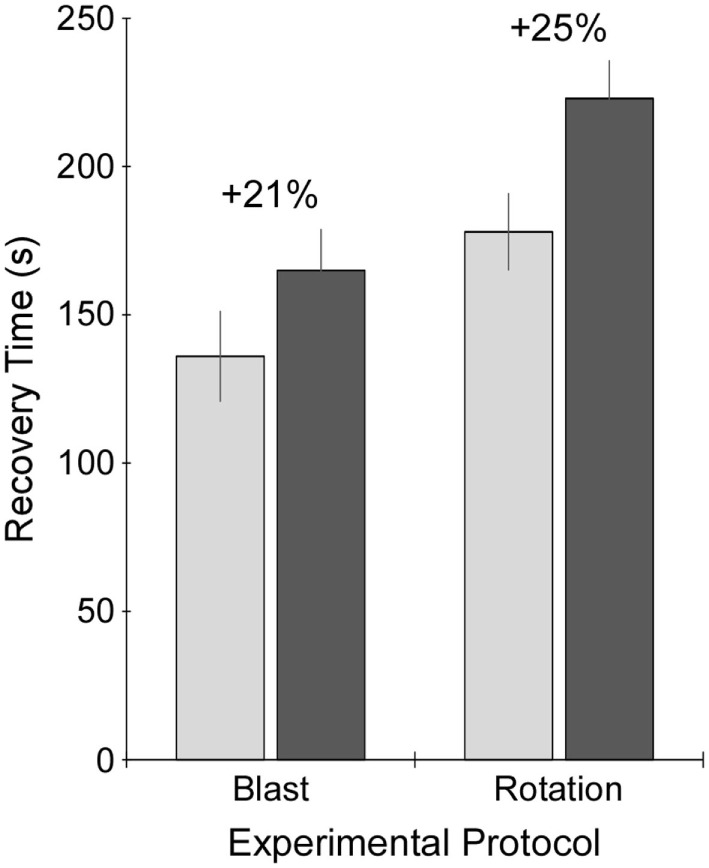
Recovery time following exposure to sham procedure (light gray), or blast or rotational injury procedure (dark gray). Recovery time was measured as the time from removal of anesthesia just prior to injury or sham procedure until return of the righting reflex. Data are presented as mean plus/minus SE.